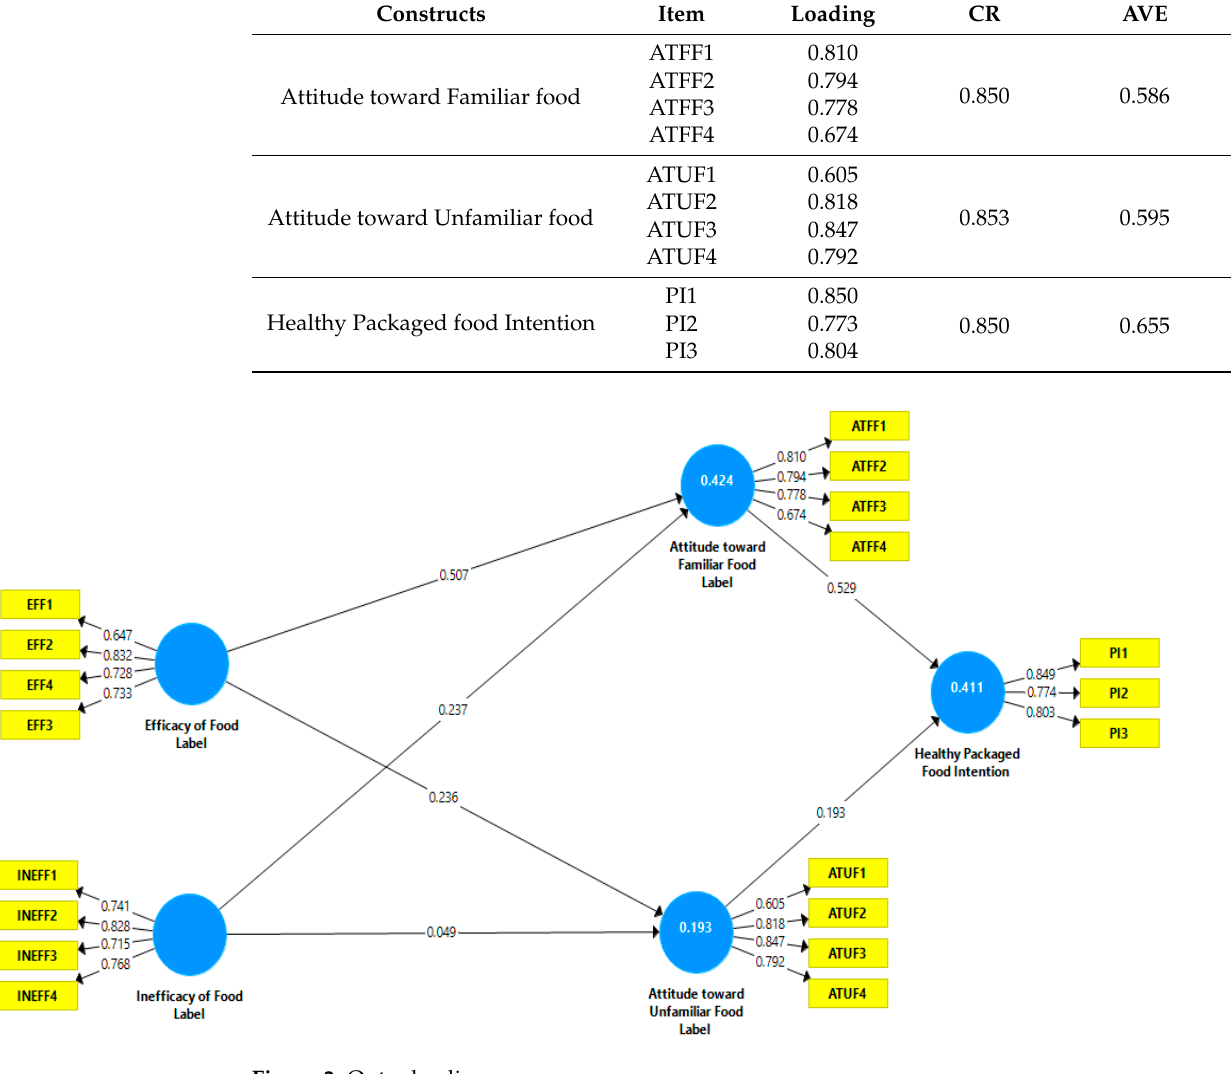
Figure 2. Outer loadings.